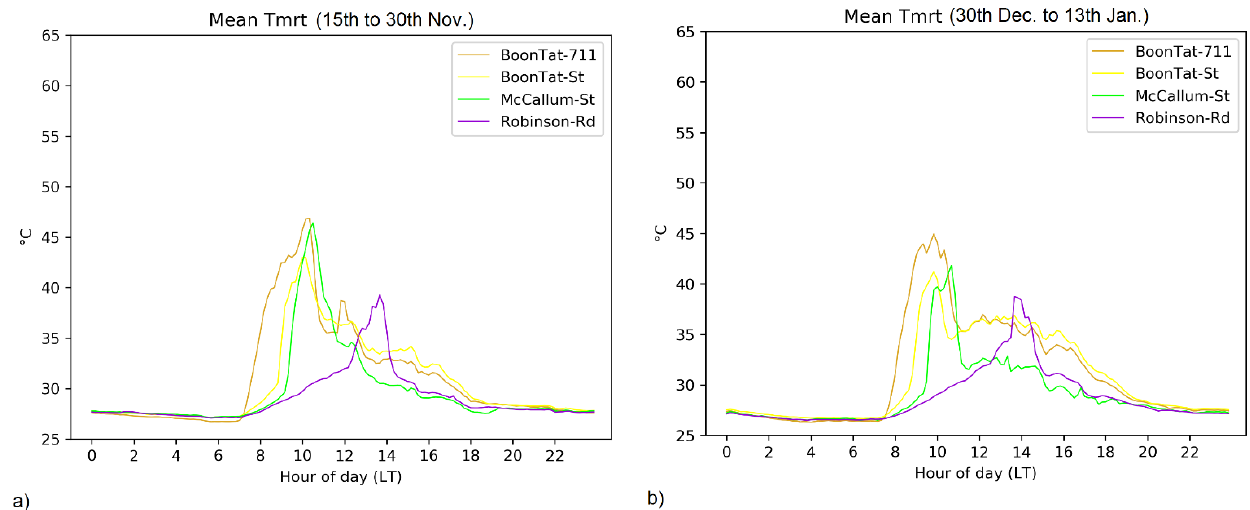
Figure 6. Mean T mrt diurnal cycle (using 10-min averaged values) in BoonTat711, BoonTatSt, McCallumSt, and RobinsonRd in the CBD in two different periods: ( a ) wet Inter-Monsoon (15 to 30 November 2019) and ( b ) wet NE-Monsoon (30 December